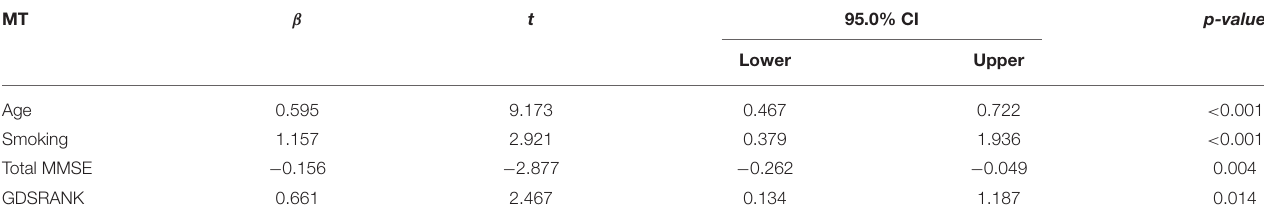
TABLE 5 | Linear regression model of MT in elderly schizophrenia inpatients. MT